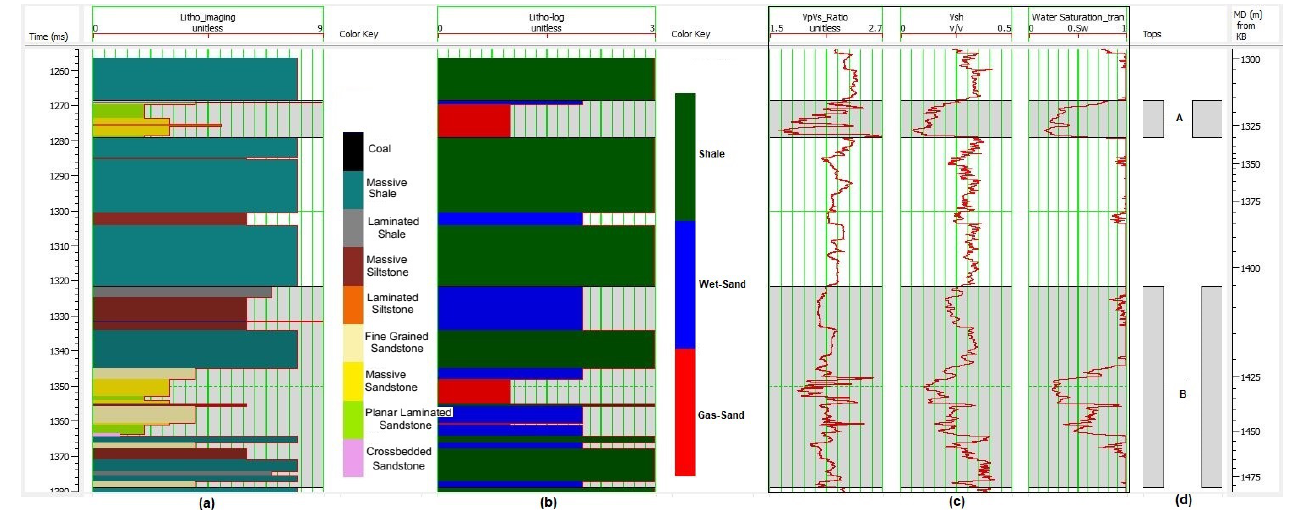
Figure 7. Well ( × ) facies and conventional logs: ( a ) OMRI-derived facies, ( b ) well-log-derived facies, ( c ) well logs, and ( d ) well